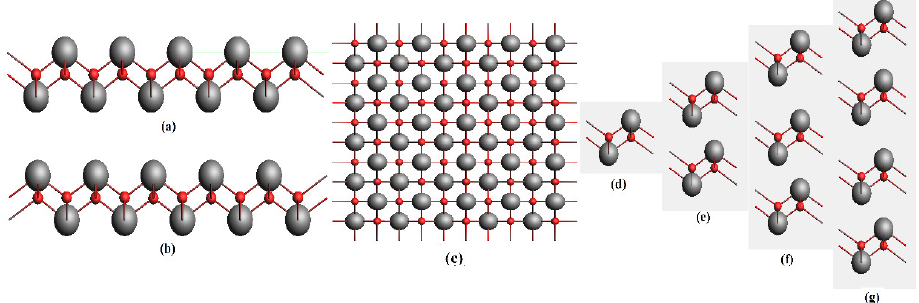
Figure 1. The structural view of 5 × 5 × 1 Supercell of SnO monolayer ( a ) viewed along the x-axis ( b ) viewed along the y-axis and ( c ) viewed from the top along the z-axis. The 2 × 2 unit cells of SnO in the form of a monolayer, two-layers, three layers and four layers are shown in ( d – g ), respectively.